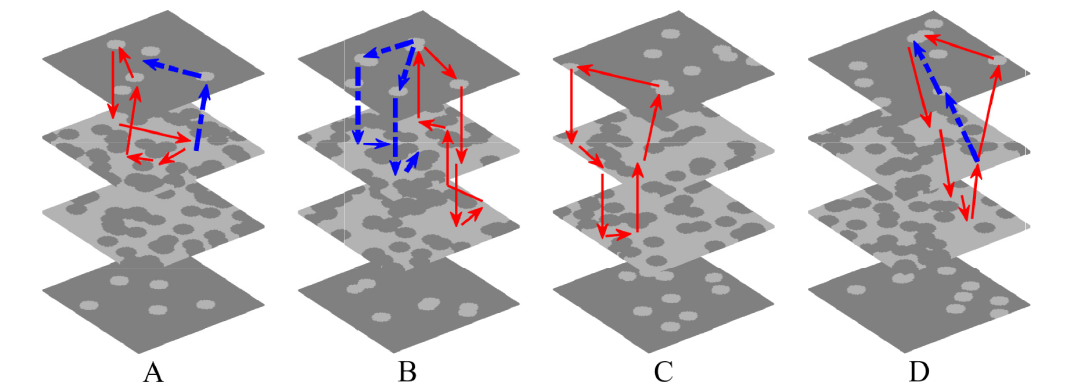
Fig 15. The intramural re-entry circuits of four stable simulations. The number of myocardial blobs in each layer and the number of fibrotic blobs in each layer are (A) 5, 50, (B) 7, 50, (C) 9, 42, and (D) 9, 46. Red arrows denote the loop lines of intramural re-entries, and blue arrows denote other possible conduction